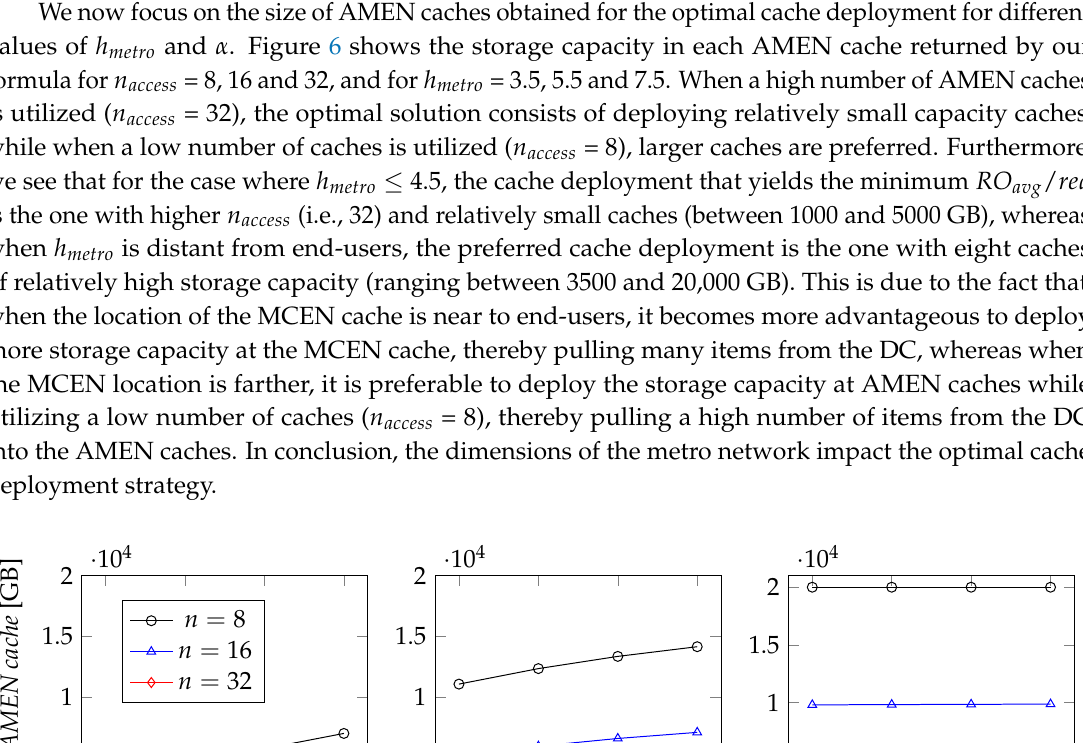
Figure 6. The amounts of storage capacity for the AMEN caches corresponding to the best cache deployment when utilizing 8, 16 or 32 caches for different values of α and h metro